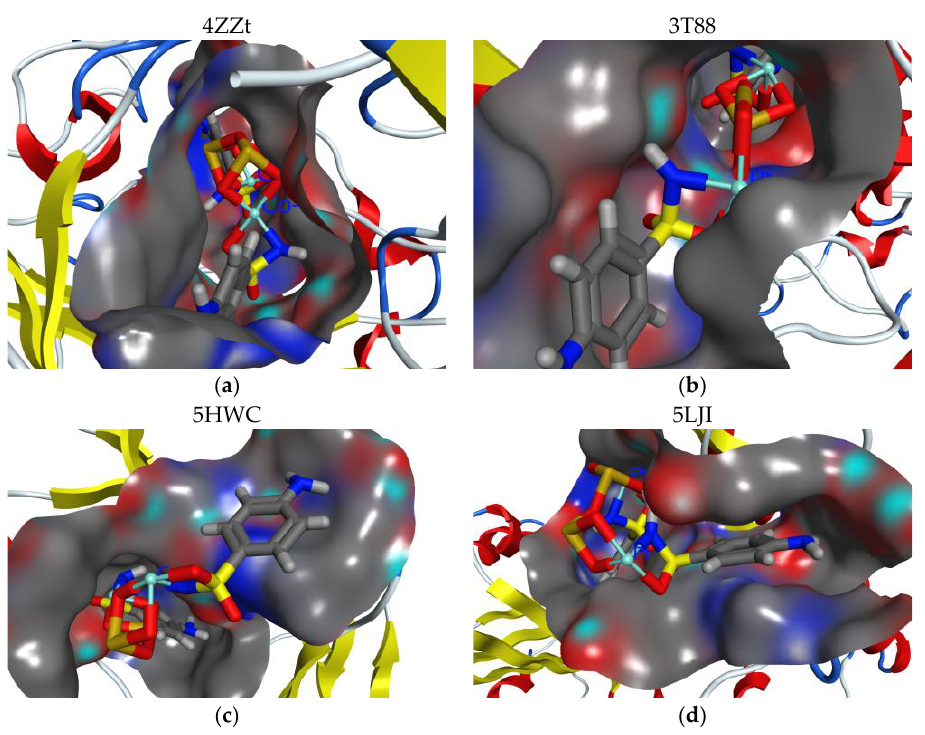
Figure 7. The Docked most active complexes into the electrostatic surface active sites of IDs: 4ZZt, 3T88,5HWC and 5LJI using MOE tool [32].